Question: Express in one sentence what the figure is showing.
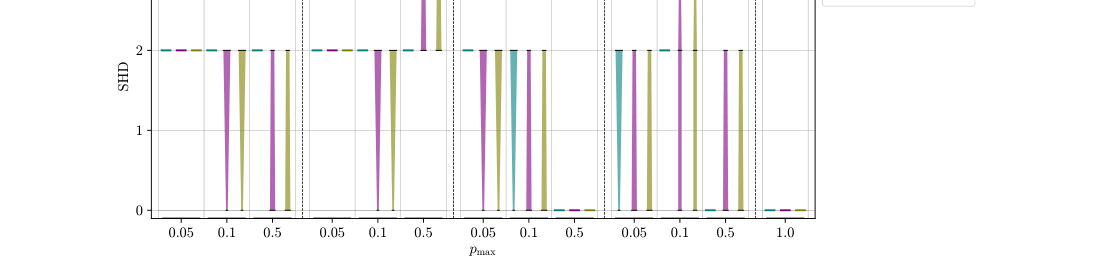
Answer: Human Stature data, SHD. Results for PC algorithm with Gaussian CI test and alpha values 0.001, 0.05 and 0.1.The width of each bar varies for different values on the y-axis proportionally to the number of samples attaining that value.